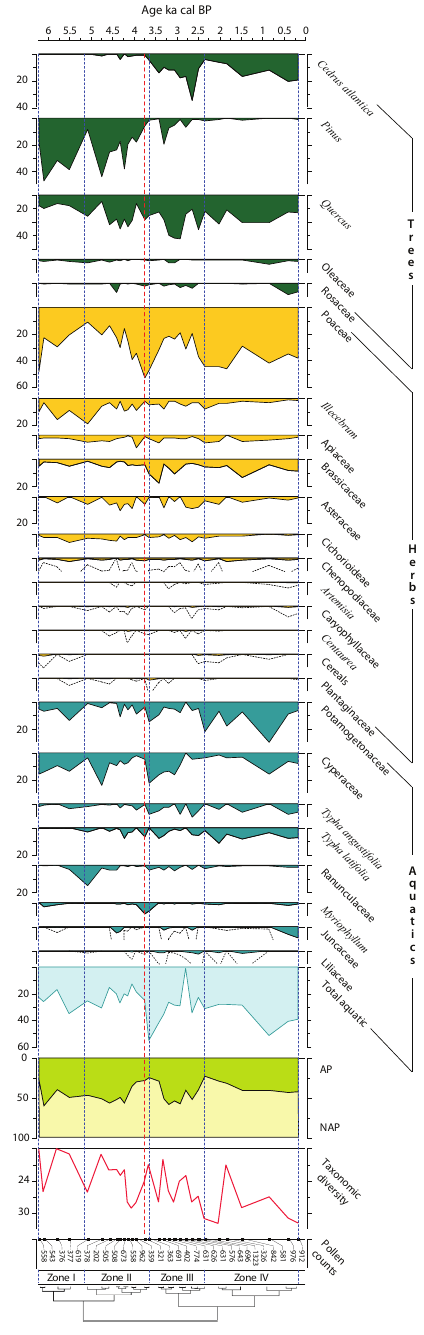
Figure 5. Diagram showing the percentages of the main pollen taxa identified in the Hach-I core. Cyperaceae and Juncaceae are included within aquatic taxa. The dashed black curves shows an exaggeration ( × 7) of the percentages of some taxa. On the right, pollen zones with their boundaries are set up using a constrained hierarchical clustering (R Development Core Team, 2013). The tax- onomic diversity is computed using a rarefaction analysis. The red line shows the limit